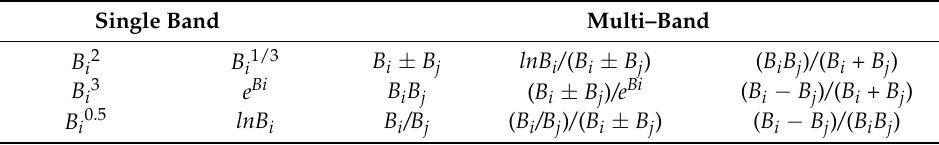
Table 3. Construction formulations of spectral